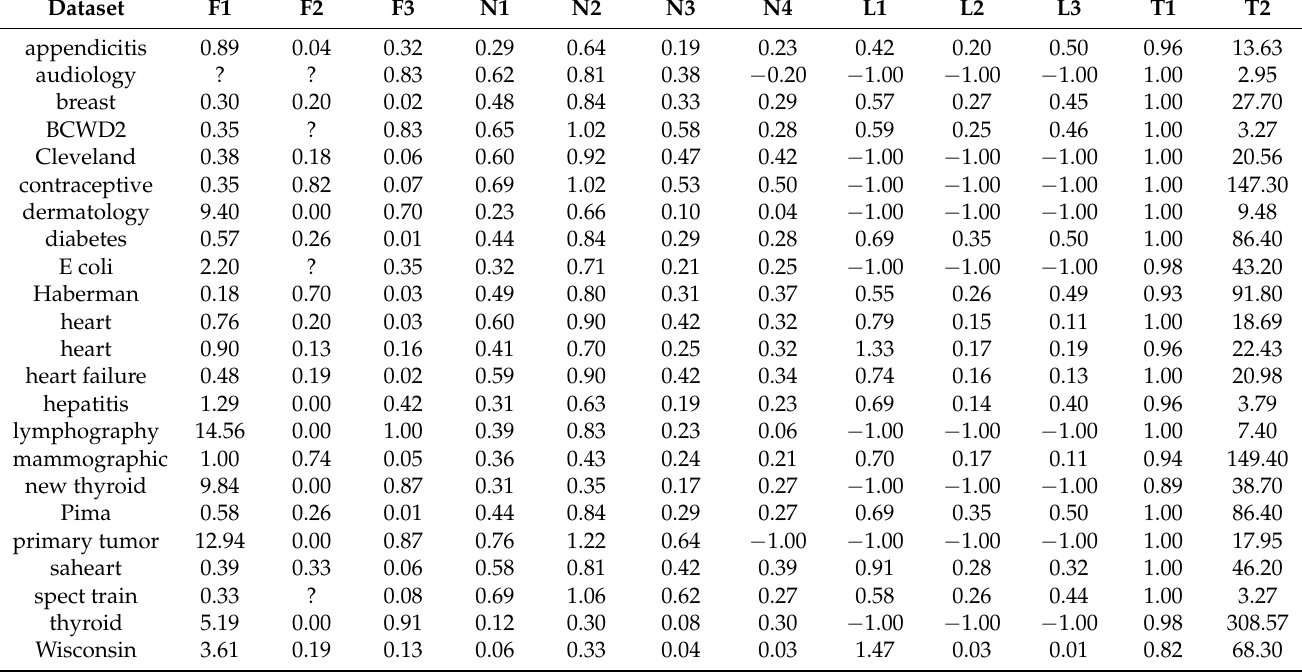
Table 2. Complexity measures of the